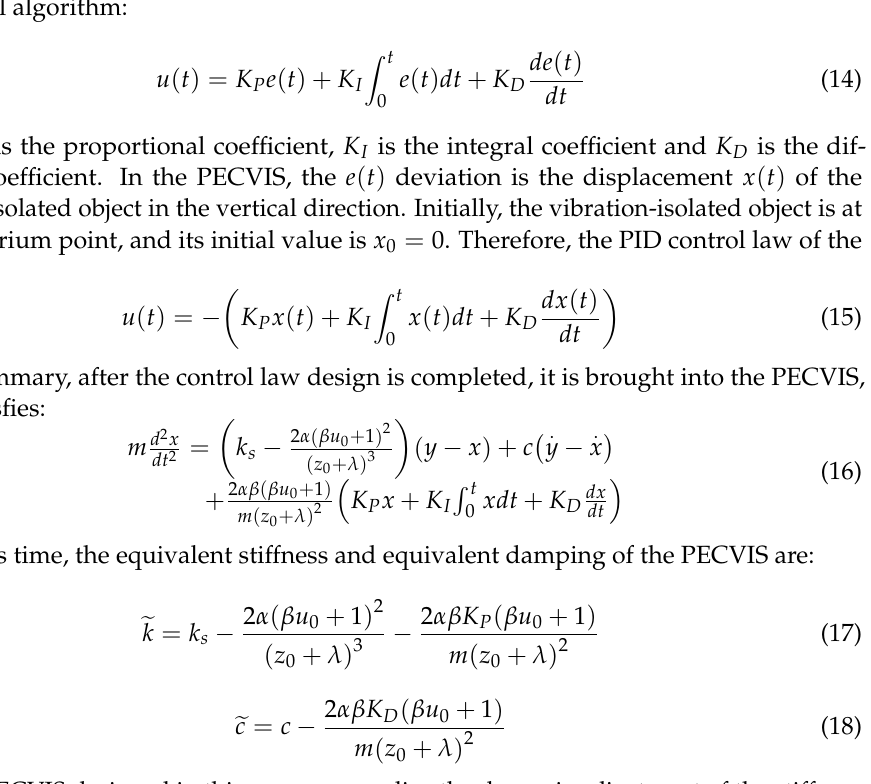
Table 6. Parameter table of the established fuzzy controller.